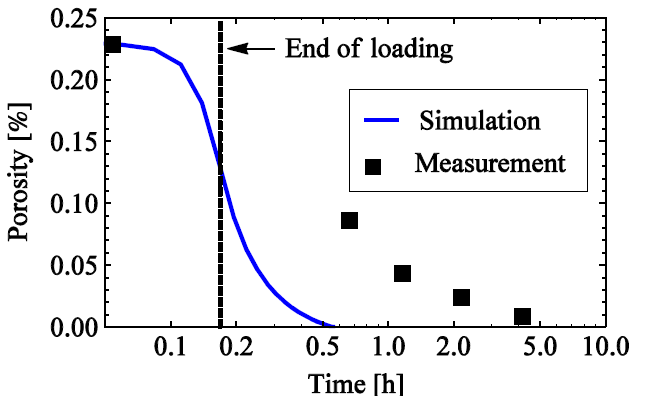
Figure 9. Kinetics of porosity decrease of SX superalloy CMSX-4 during HIP 1288 °C/103 MPa predicted by the modelling in comparison with the results of density measurements [48] .